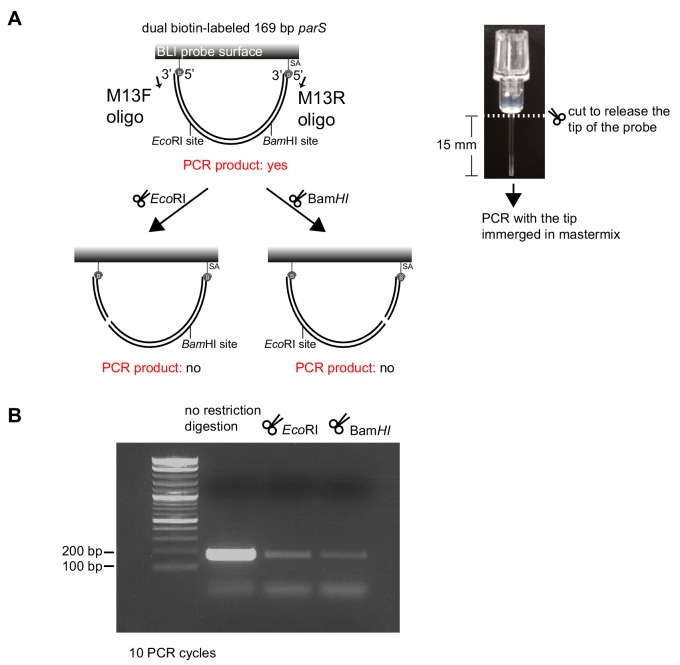
Restriction enzymes linearize dual biotin-labeled DNA fragments on the surface of the BLI probe.(A) (Left panel) A schematic of a digestion assay using BamHI/EcoRI and PCR. PCR was performed using M13F, M13R oligos, and DNA attached to the BLI surface as a template. (Right panel) The BLI probe was severed from the plastic adaptor and immerged into a PCR master mix. (B) Detection of intact 169 bp DNA fragments that were bound on the surface of the BLI probe before and after treatment with restriction enzymes.Figure 3—figure supplement 1—source data 1.Data used to generate Figure 3—figure supplement 1.